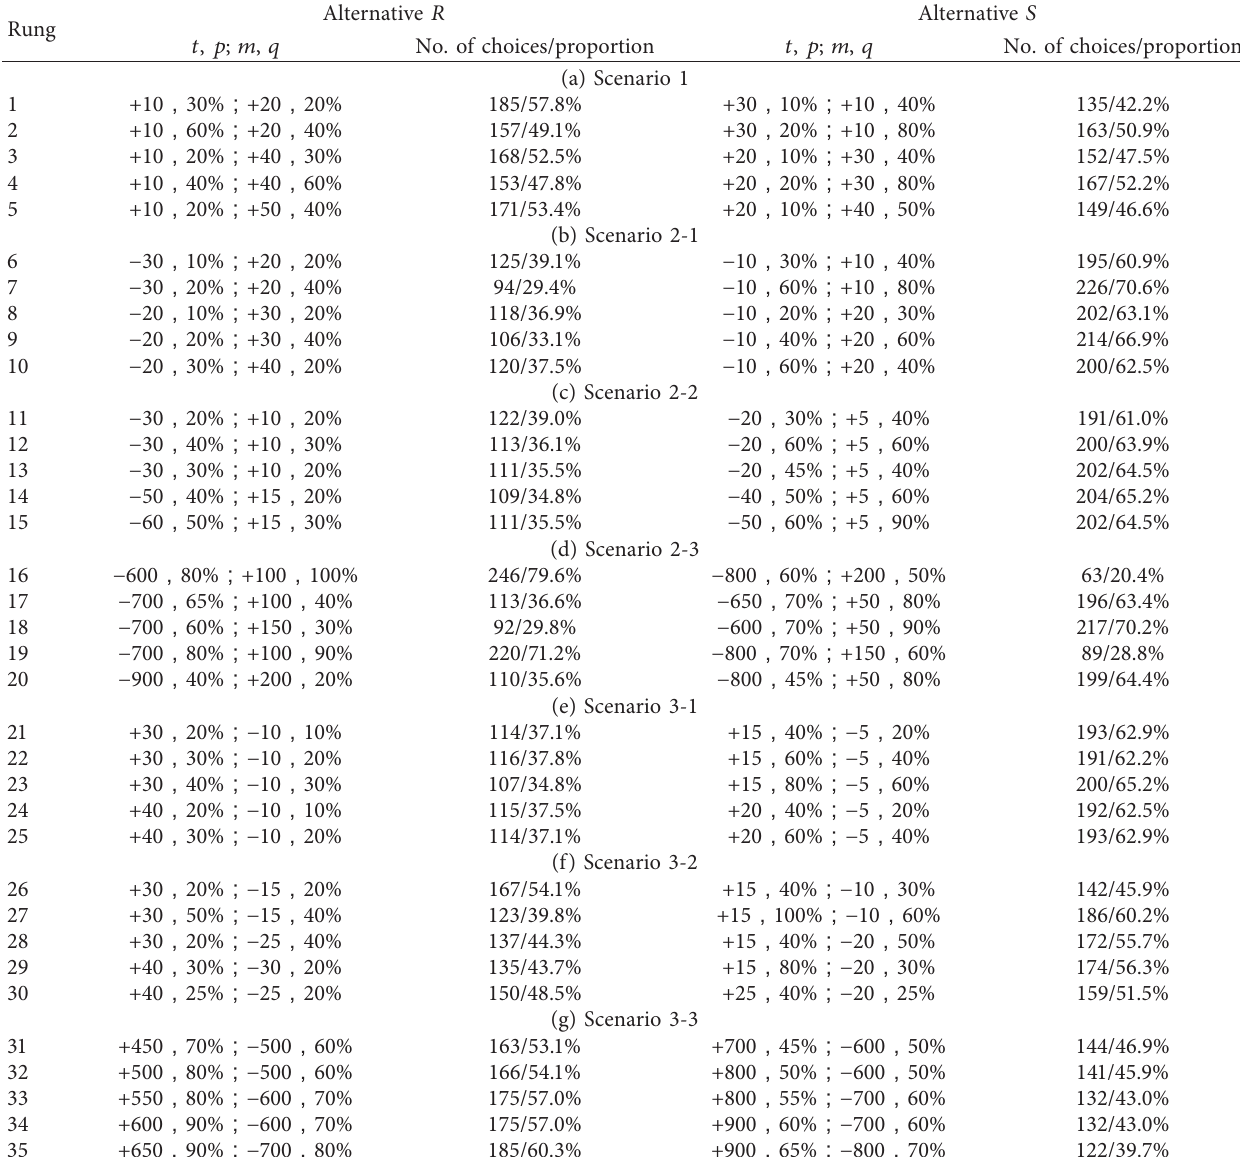
Table 2: Travel choice results of different scenarios under risky